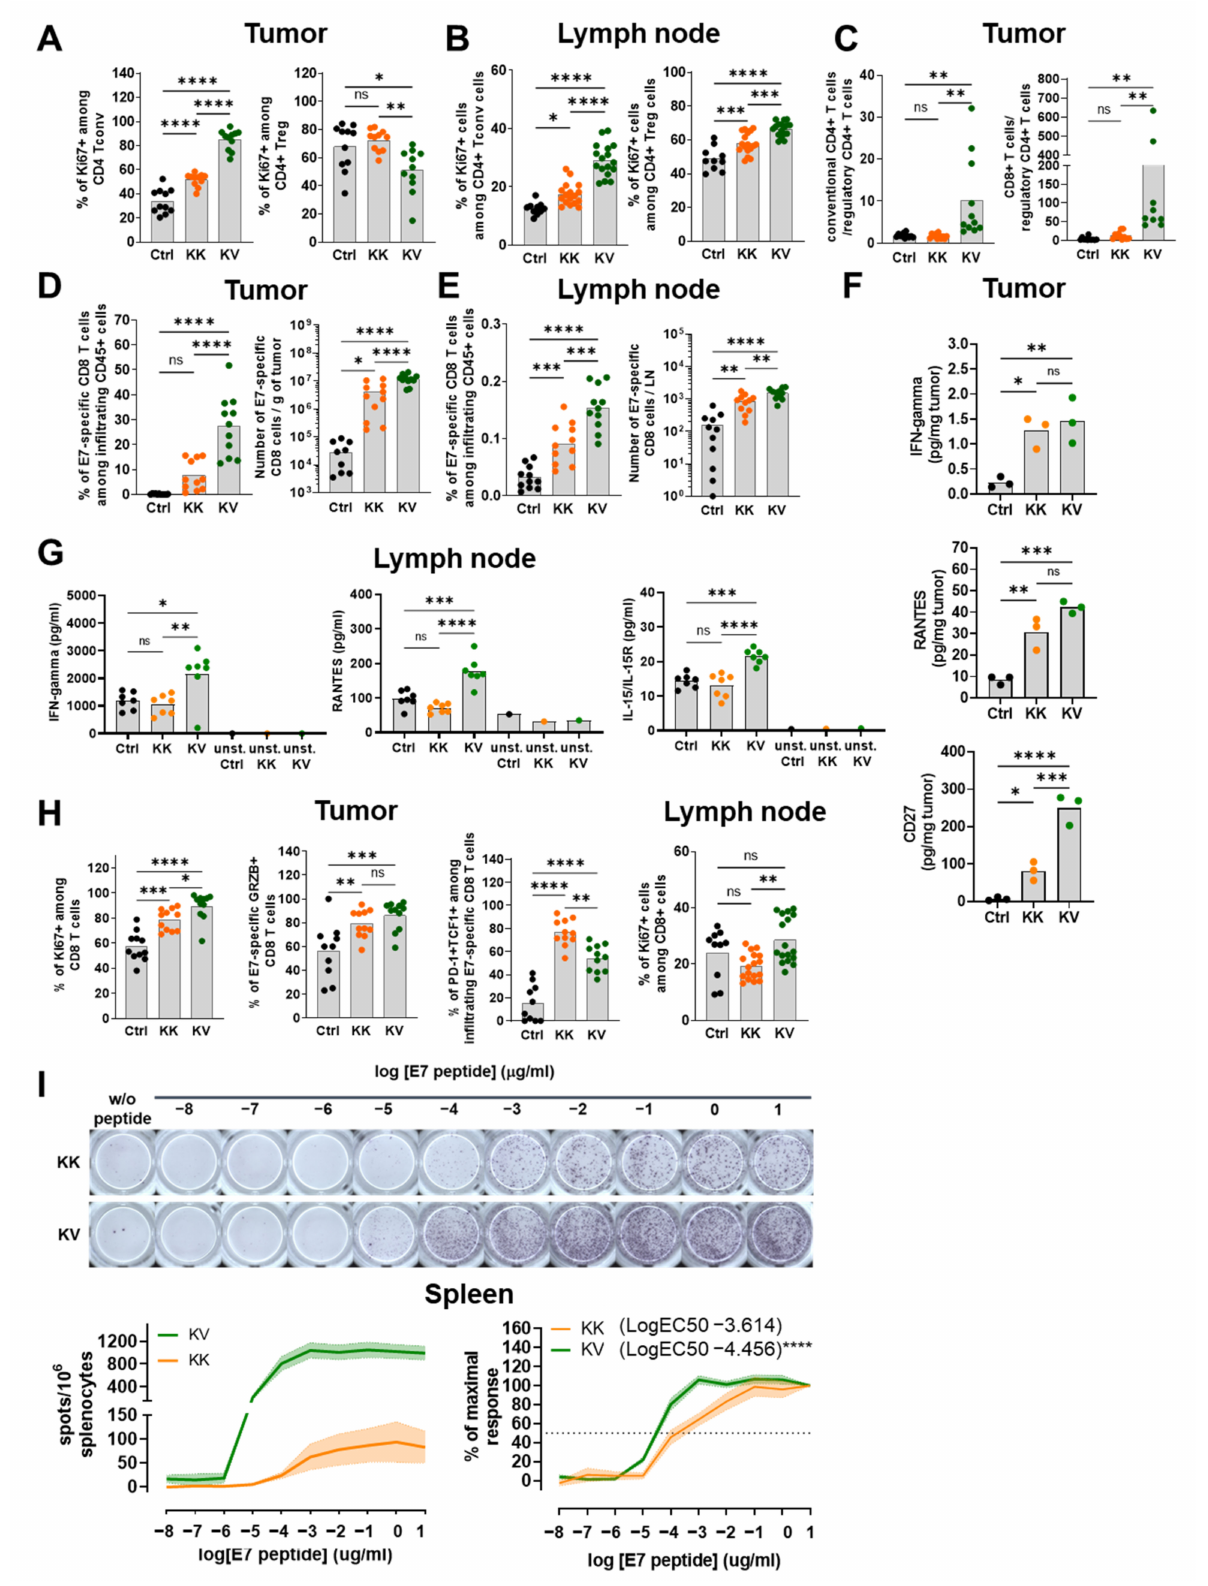
Figure 2. Improved CD4+ and CD8+ T-cell characteristics in tumor and tumor-dLNs and TCR avidity in the spleen of heterologous-treated TC-1 tumor-bearing C57BL/6 mice. ( A ) % of intratumoral Ki67+ cells among FoxP3- CD4+ Tconv cells (Tconv-right side) or % of intratumoral Ki67+ cells among FoxP3+ CD25+ CD4+ regulatory T cells (Treg-right side)